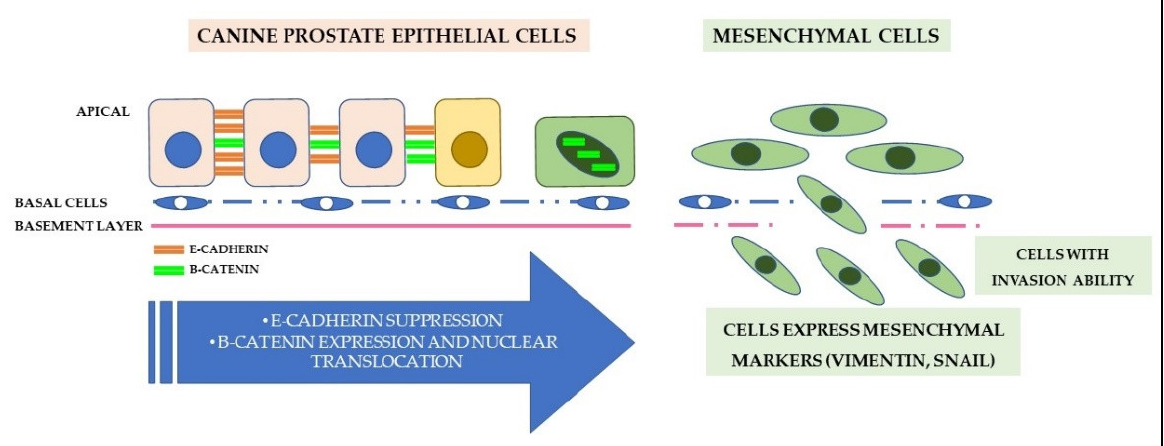
Figure 4. Loss of cell adhesion and epithelial-mesenchymal transition of canine PC. Canine prostate tumor cells overexpress β-catenin, which is accumulated in the cell nucleus, binding to transcription factors to activate gene expression. Concomitantly, there is suppression of E-cadherin, resulting in important structural changes, such as loss of adhesion of neoplastic cells. Following this process, especially in tumors with a lower degree of cell differentiation, tumor cells undergo immunophenotypic changes, expressing mesenchymal markers (vimentin and snail). Such mechanisms significantly influence the process of invasion, migration and metastasis of neoplastic cells.